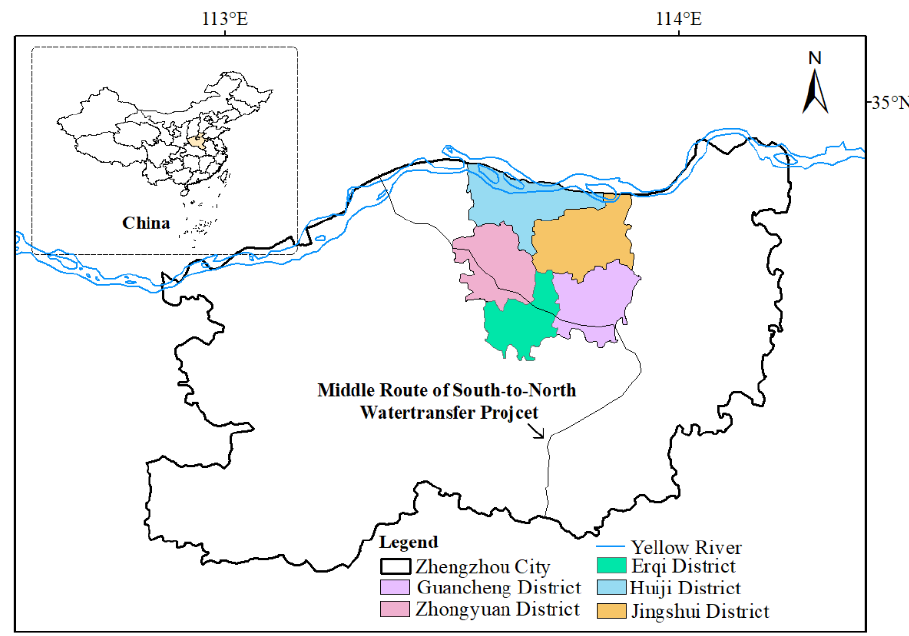
Figure 1. Location of Zhengzhou city.